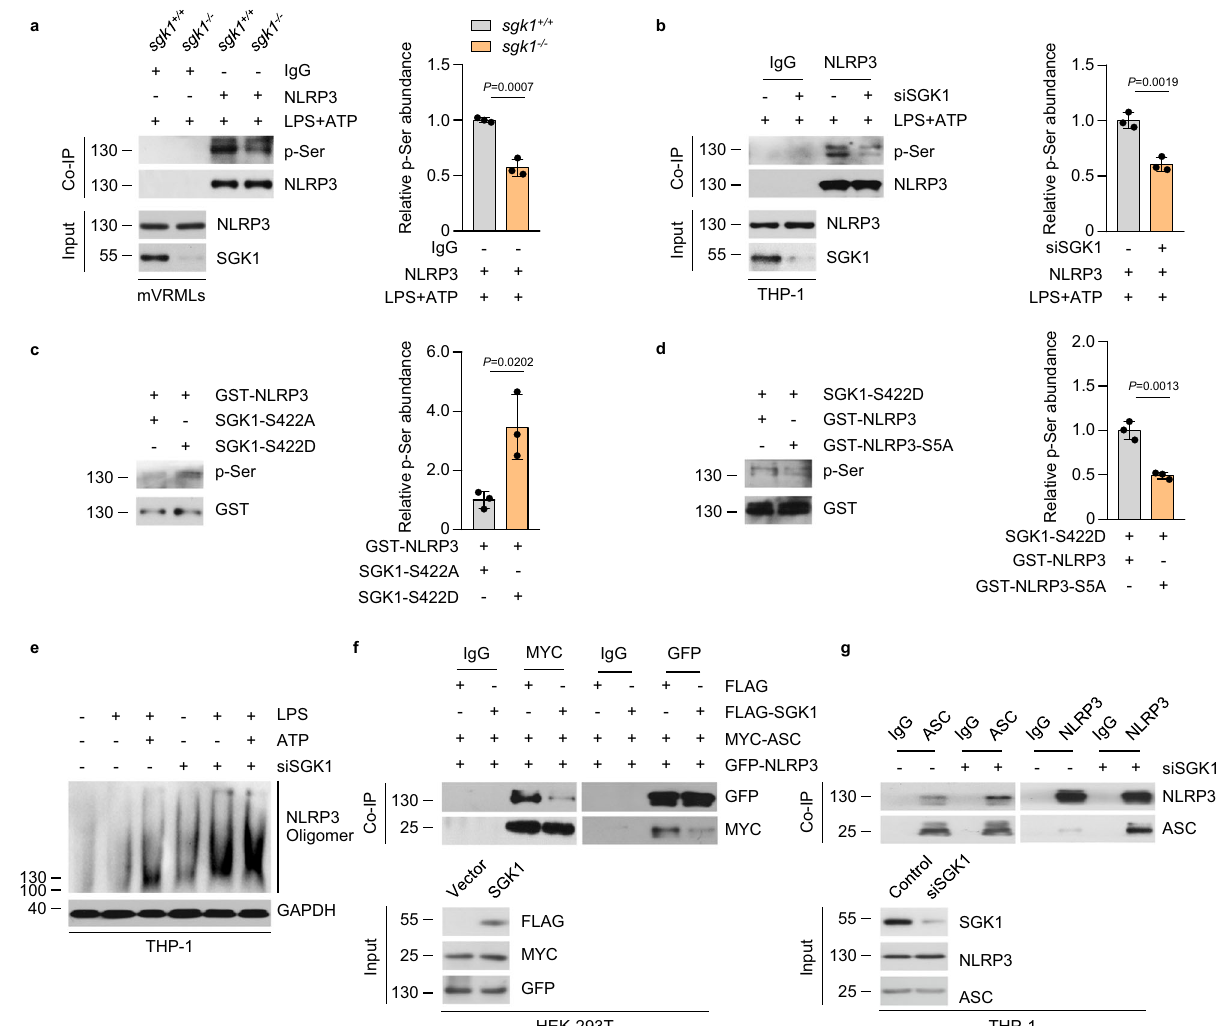
Fig. 4 | SGK1 phosphorylates NLRP3 at serine 5 and inhibits in fl ammasome formation. a Co-IP analysis of the serine phosphorylation of NLRP3 from the total lysates of primary mVRML cells of sgk1 +/+ or sgk1 − / − mice upon stimulation with LPS (200ng/mL, 3h) and ATP (5mM, 30min). b Co-IP analysis of the serine phos- phorylation ofNLRP3 from the totallysates ofcontrol and SGK1 siRNA-transfected THP-1 cells, which were stimulated with LPS (200ng/mL, 3h) and ATP (5mM, 30min). c In vitro kinase assay results showing the serine phosphorylation of NLRP3afterincubationwithactiveSGK1-S422DorinactiveSGK1-S422Aviawestern blottinganalysis. d Invitrokinaseassayresultsshowingtheserinephosphorylation of wild-type NLRP3 or NLRP3-S5A after incubation with active SGK1-S422D via westernblottinganalysis. a – d ,Proteinexpressionwasquanti fi edbygrayscanning, n =3biologicallyindependentexperiments. a , b NLRP3served asaloading control